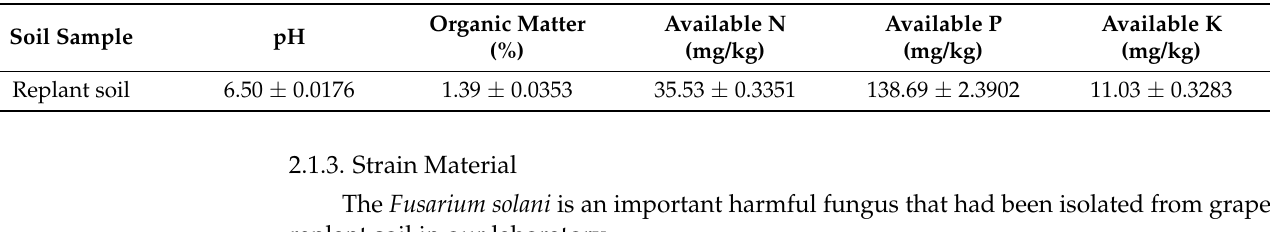
Table 1. Physicochemical properties of grape replant